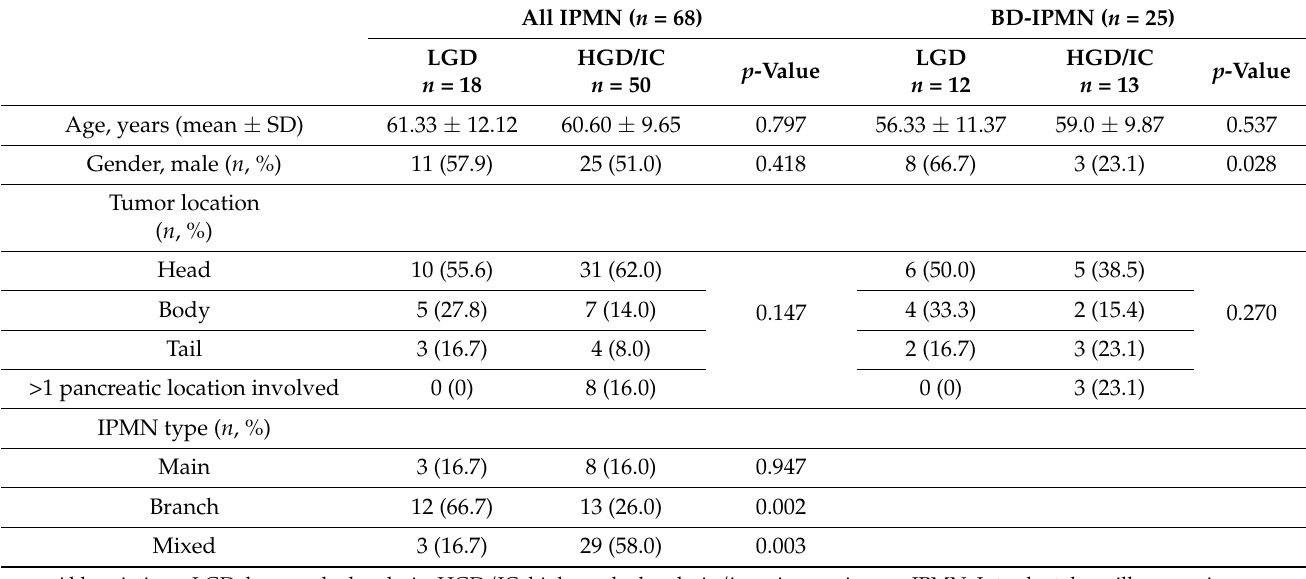
Table 2. Demographic data of all the patients with papillary mucinous neoplasm and patients with branch duct-IPMN.